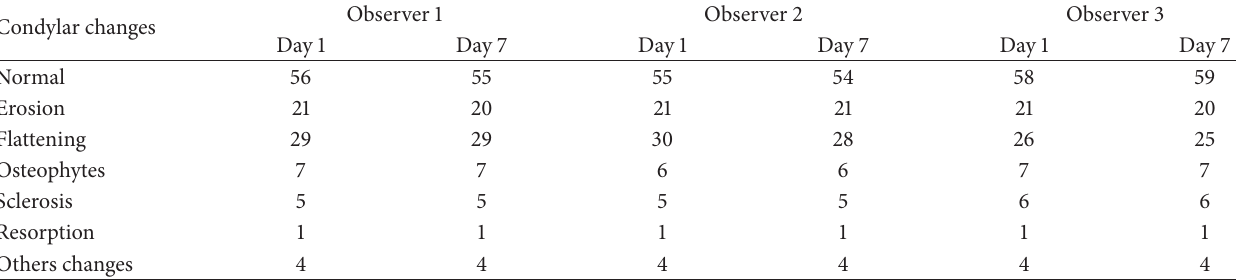
Table 4: Bony changes seen by three observers in DVT.